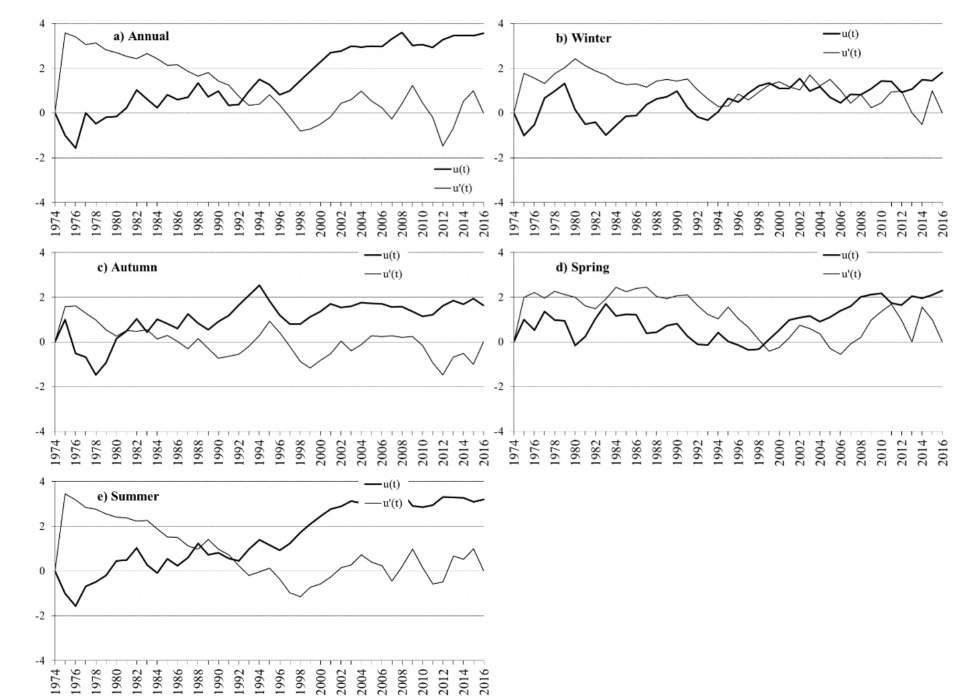
Figure 4. Graphical representation of the series u ( t ) and the retrograde series u ’( t ) of the sequential version of the Mann–Kendall test for ( a ) annual, ( b ) winter, ( c ) autumn, ( d ) spring, and ( e ) summer PET in the University Forest of Pertouli.